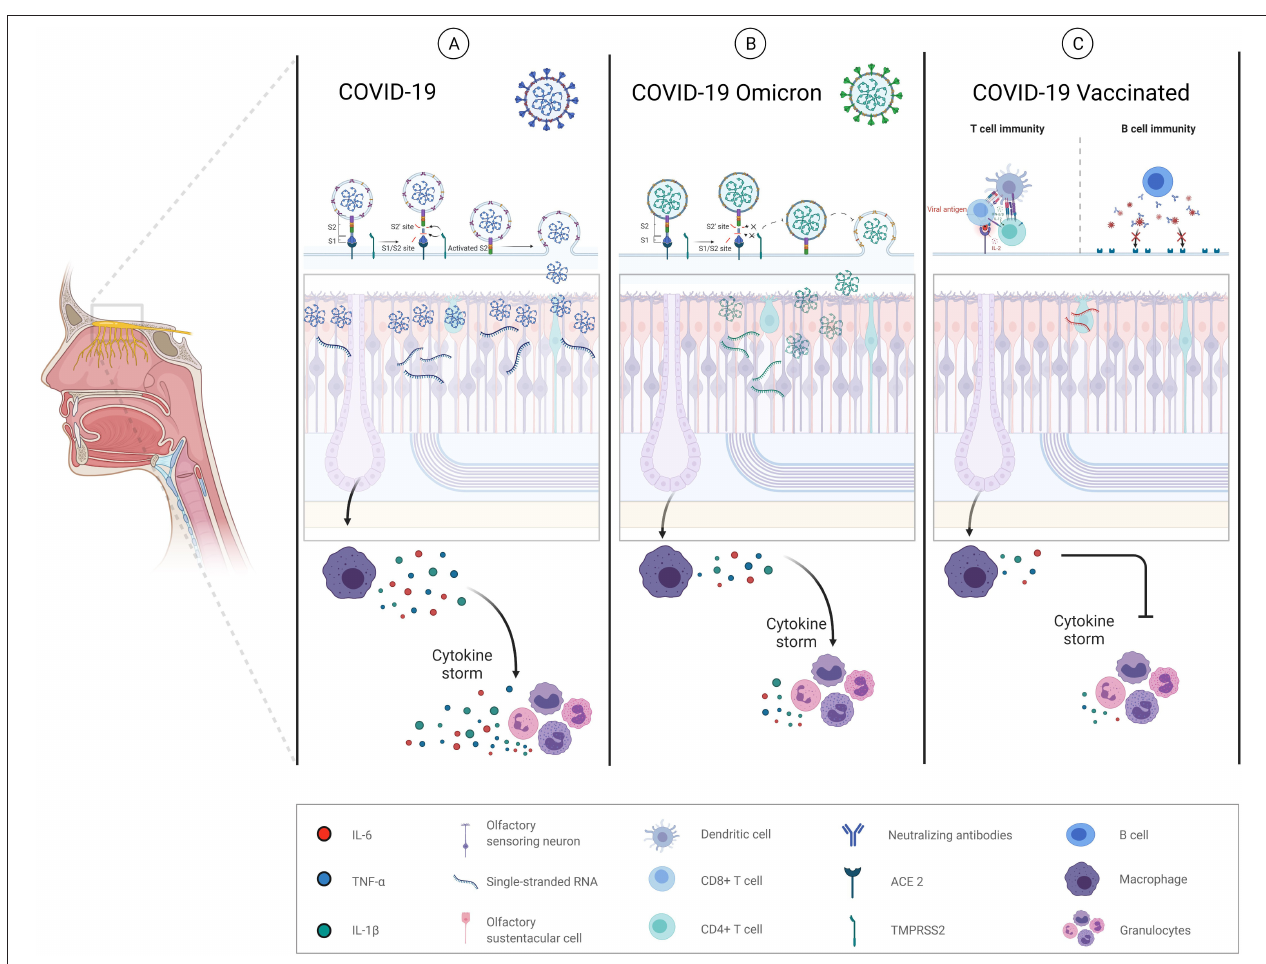
FIGURE 1 | Schematic mechanism proposal of anosmia/hyposmia in COVID-19. (A) SARS-CoV-2 alpha variant. (1) Infection and destruction of olfactory epithelial supporting cells (olfactory sustentacular cells), resulting in inflammation, and abnormalities in local homeostasis; (2) infection or immune-mediated damage of surrounding cells (vascular cells) resulting in hypoperfusion, inflammatory cell recruitment, cytokine release, and the production of chemical neurotoxins. (B) SARS-CoV-2 Omicron variant. Omicron mechanism of cell entry based on a TMPRS22 dependent and non-dependent manner may involve a more heterogenous tropism with less replication and the consequent minor local inflammation produced. (C) SARS-CoV-2 vaccines may not alter the levels of replicating virus in the olfactory epithelium once viral infection establishes but may instead protect through accelerated clearance or enhanced neutralization of infectious viral